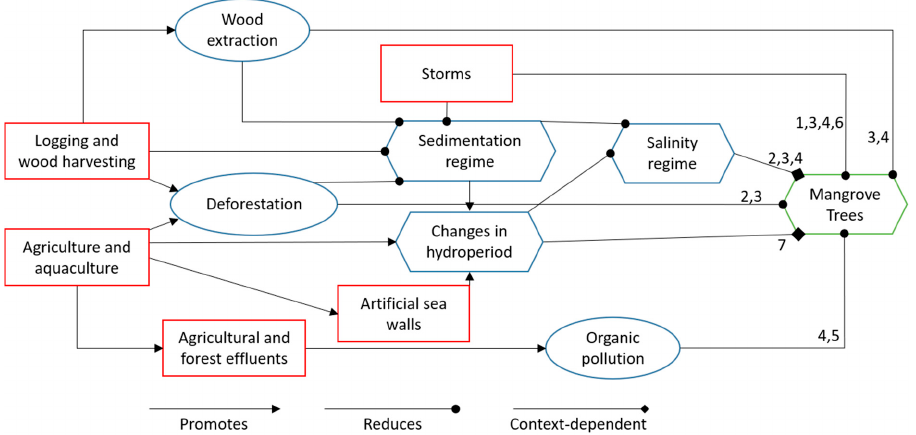
Figure 2. Simplified conceptual model of the threats and the ecological processes relevant to mapping mangrove degradation in our analysis. Red boxes indicate threats, blue ovals represent the abiotic processes, blue hexagons represent the abiotic environment, and the green hexagon represents the biotic components of the mangrove ecosystem. Pointed arrowheads indicate positive effects, rounded arrowheads indicate negative effects, and diamond arrowheads indicate context-dependent effects. Numbers show potential satellite-derived variables to be used to detect specific ecological links contributing to mangrove degradation from Table 1. A more complete model is presented in Figure S1. Table 1. Satellite-derived variables and their ecological link to mangrove degradation. Variables were identified with a conceptual model of mangrove ecosystems (Figure 2).